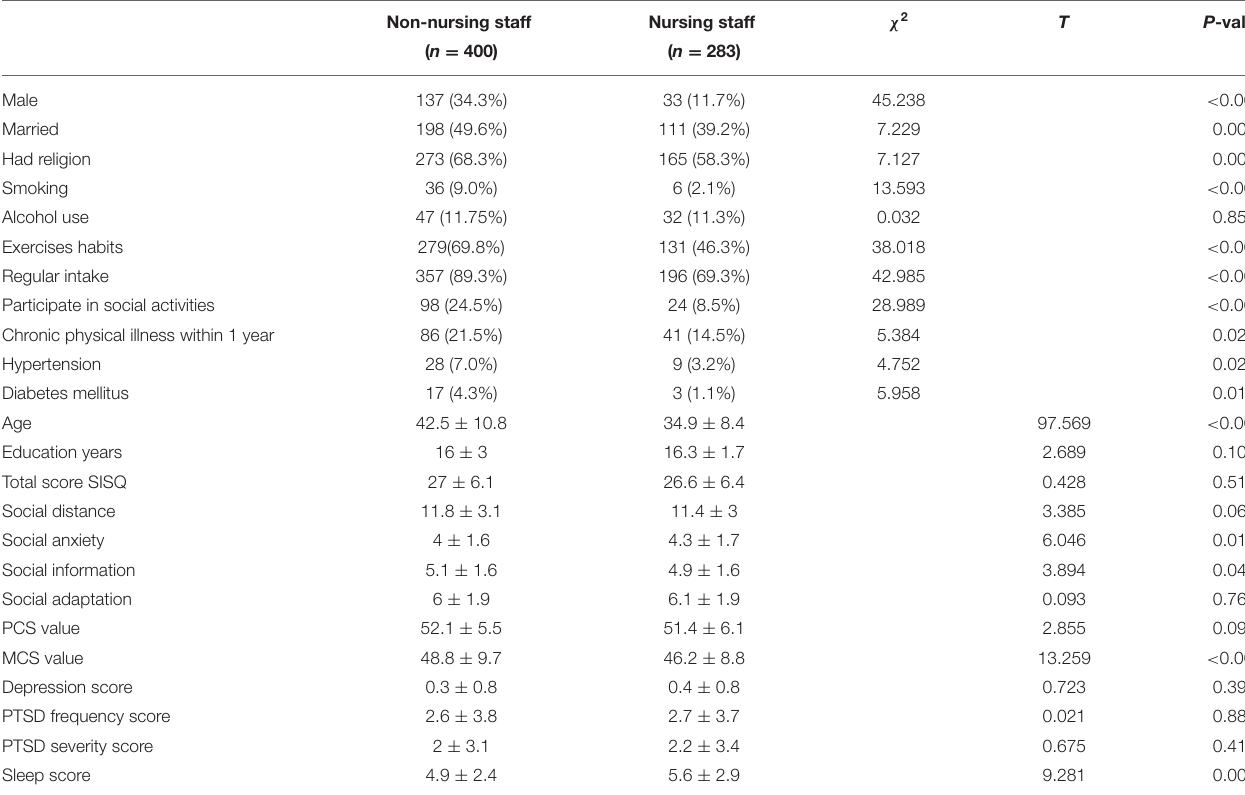
TABLE 1 | The difference of demographic data and questionnaires between nursing staff and non-nursing staff. Non-nursing staff Nursing staff χ